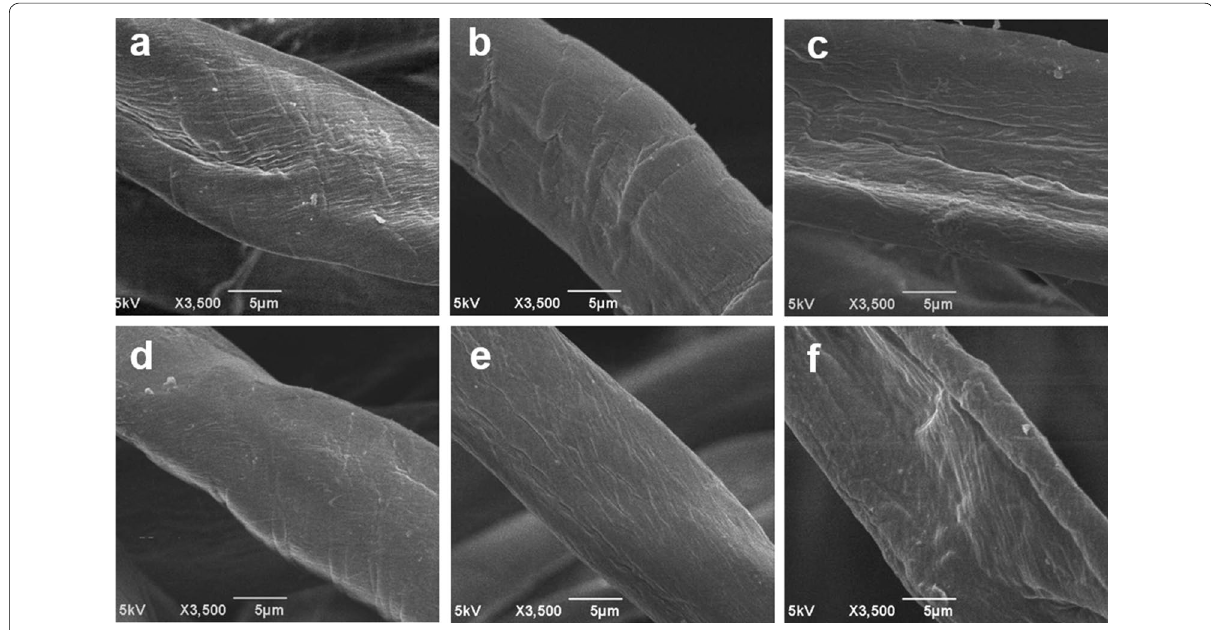
Fig. 4 SEM micrographs of cotton fibers treated with a inactivated cutinase, b alkaline scouring, c WT-CBMCenA, d L90A-CBMCenA, e